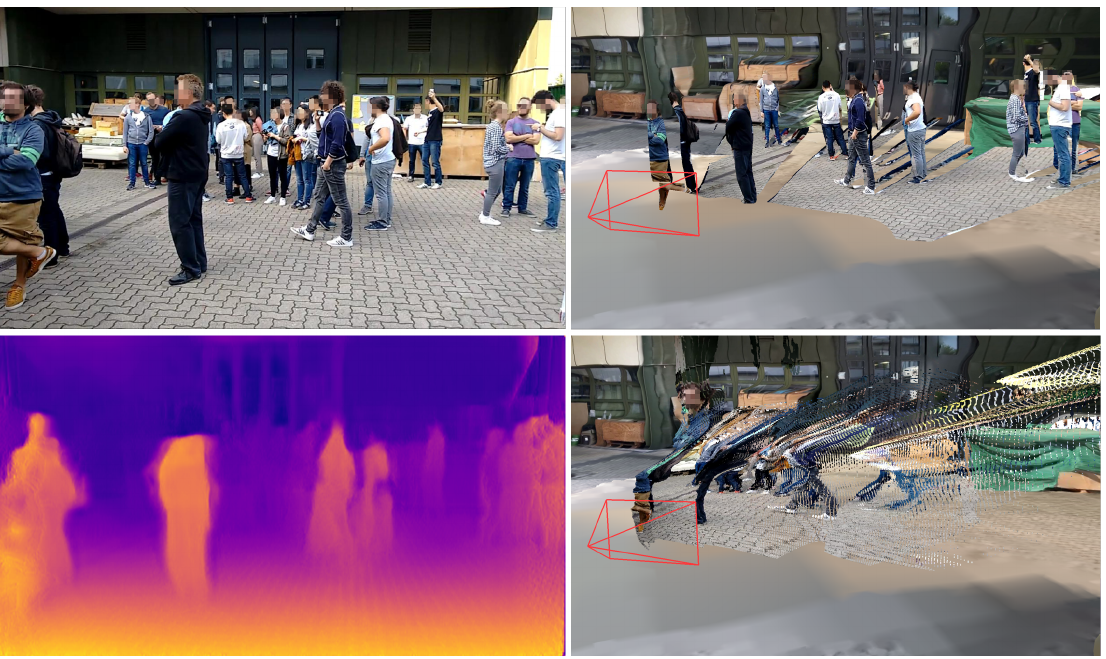
Figure 4. ( Top left ) Input image. ( Top right ) Result of our method, in which people are segmented and placed upright on the ground.( Bottom left ) Resulting depth map using Monodepth2. ( Bottom right ) Embedded point cloud generated using